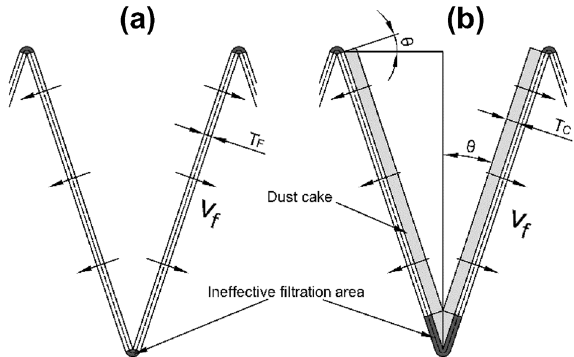
Figure 8. Dust deposition on the V-shaped